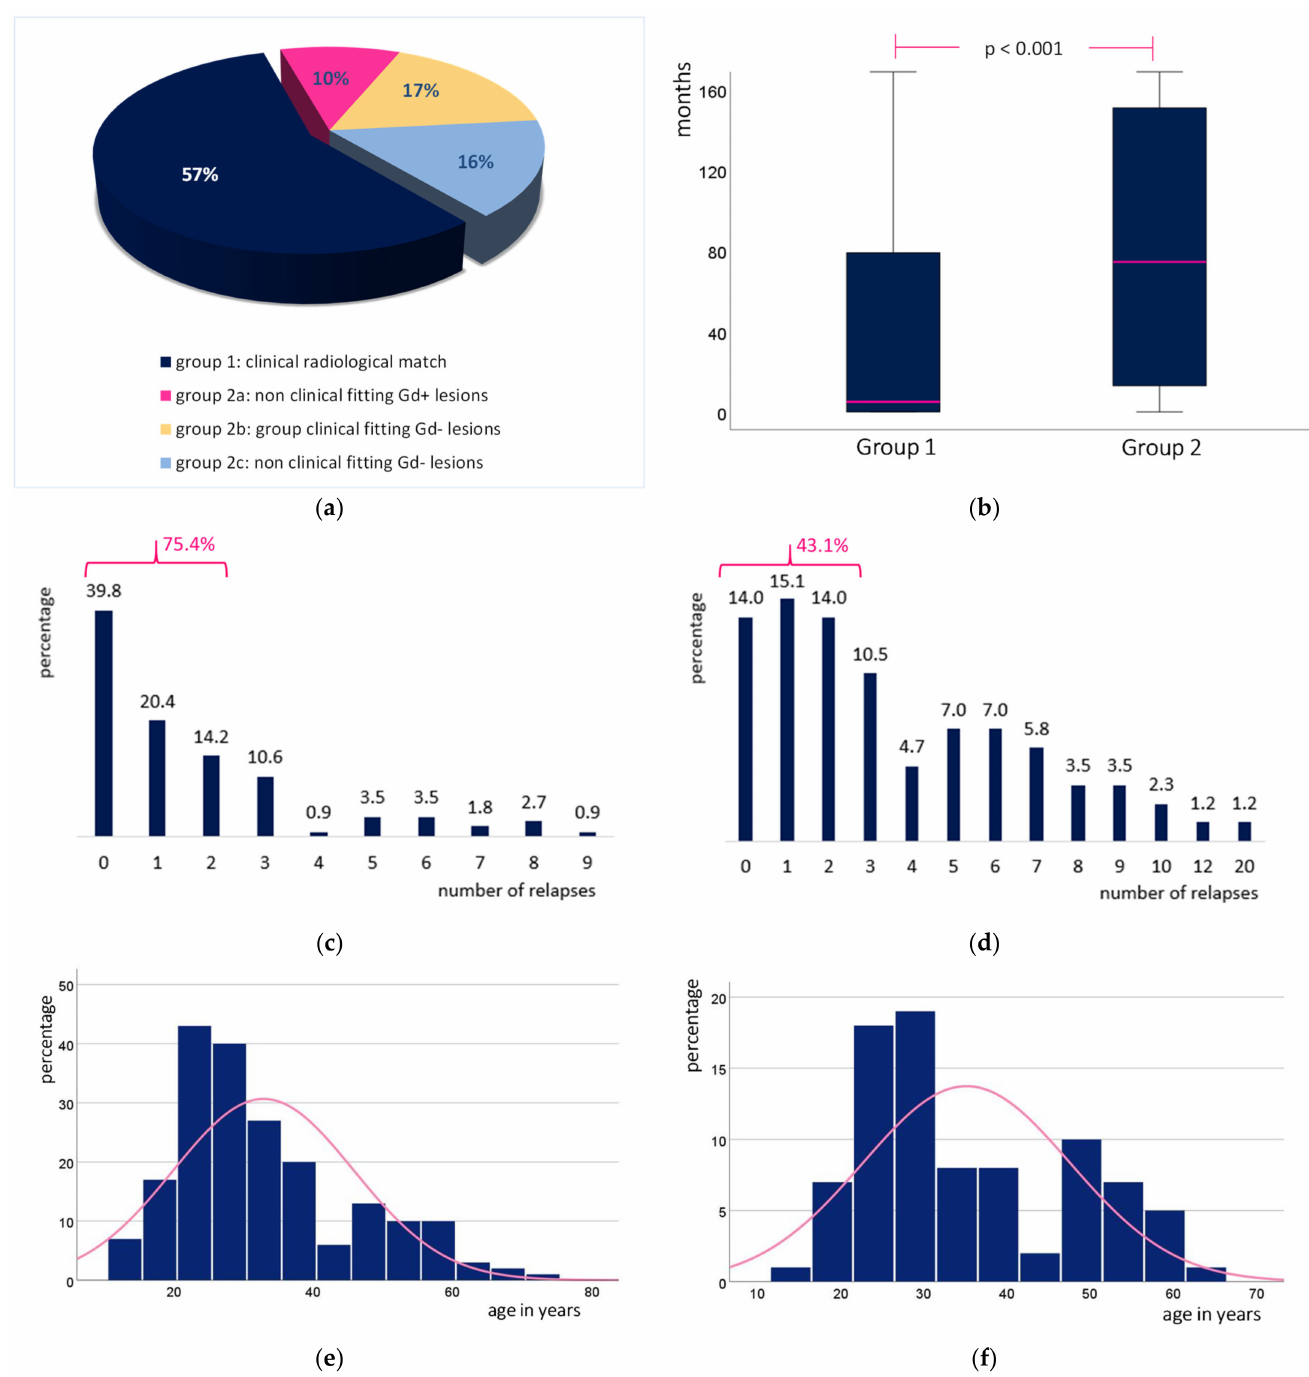
Figure 1. ( a ) Patient distribution. ( b ) Disease duration. ( c ) Number of previous relapses in group 1. ( d ) Number of previous relapses in group 2. ( e ) Age on acute relapse in group 1. ( f ) Age on acute relapse in group